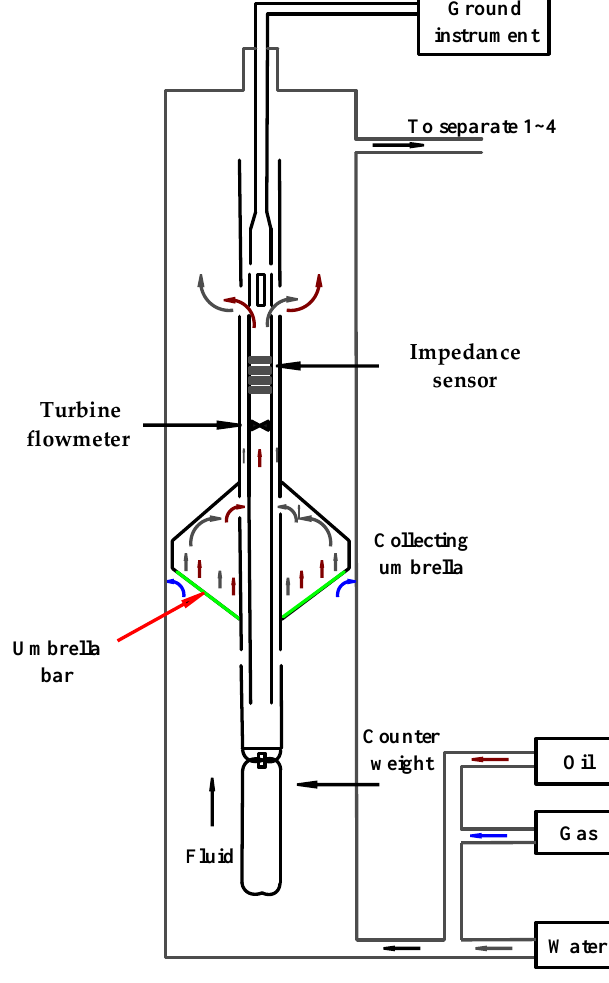
Figure 9. Multiphase flow device of DGLS structure experimental prototype.